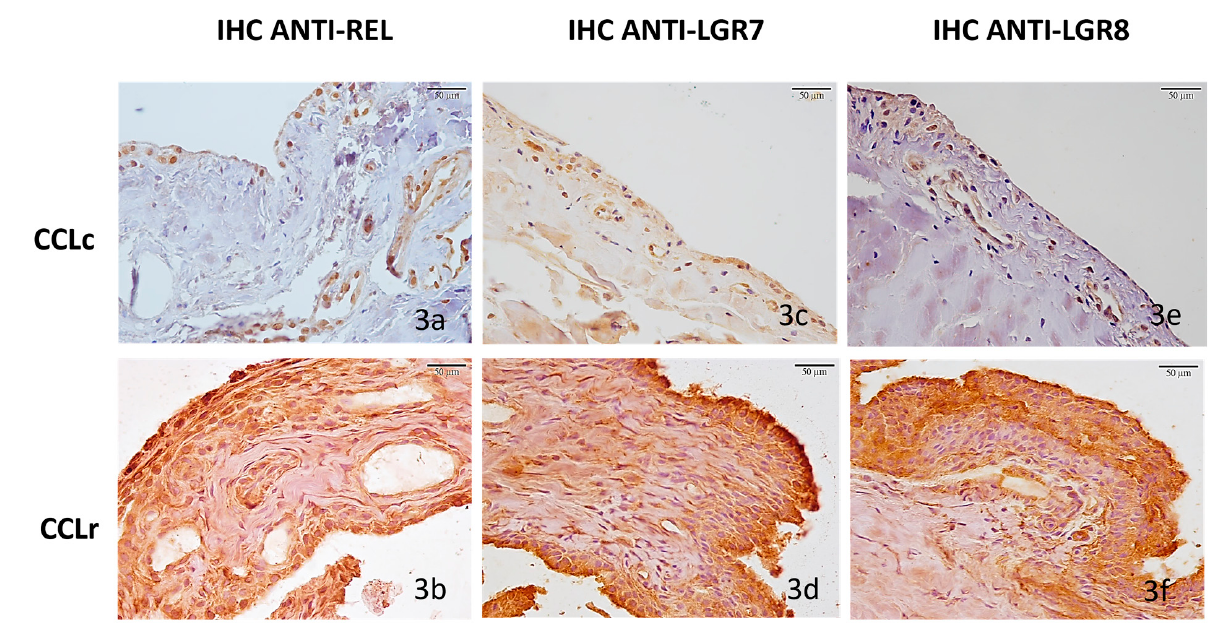
Figure 3. Immunohistochemical labeling of relaxin, LGR7, and LGR8 receptors in synovial membranes of control dogs (CCLc) and synovial membranes of dogs with CCLr. ( a ) Control case 3, relaxin IHC, IRS = 1, weak diffuse cytoplasmatic immunoreactivity in 8.7% of synoviocytes. Relaxin- immunostaining was also evident in vascular endothelial cells. ( b ) SMr of CCLr case 14, relaxin IHC, IRS = 9, strong diffuse cytoplasmatic immunoreactivity in 36.2% of synoviocytes. ( c ) Control case 3, LGR7 IHC, IRS = 2, moderate immunoreactivity on the cell membranes in 9.7% of synoviocytes, and on vascular endothelial cells ( d ) CCLr, case 14, LGR7 IHC, IRS = 9, strong membranous immunoreactivity in 33.9% of fibroblast-like cells. ( e ) Control case 3, LGR8 IHC, IRS = 2, moderate diffuse, cytoplasmatic immunoreactivity in 7.9% of synoviocytes. ( f ) CCLr, case 14, LGR8 IHC, IRS = 6, strong membranous immunostaining as well as diffused cytoplasmatic staining in 28.2% of fibroblast-like cells. Scale bars 50 µ m.